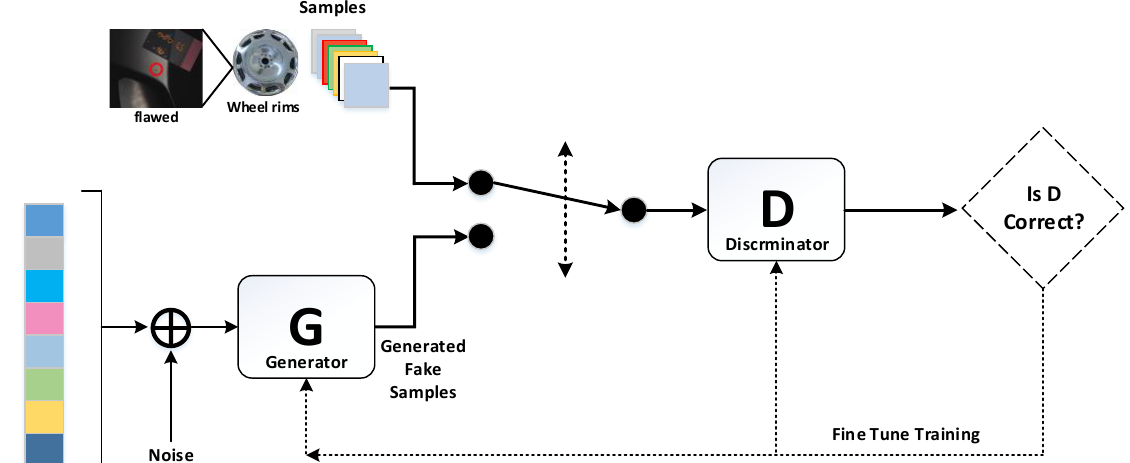
Figure 11. The basic architecture of the GAN network.